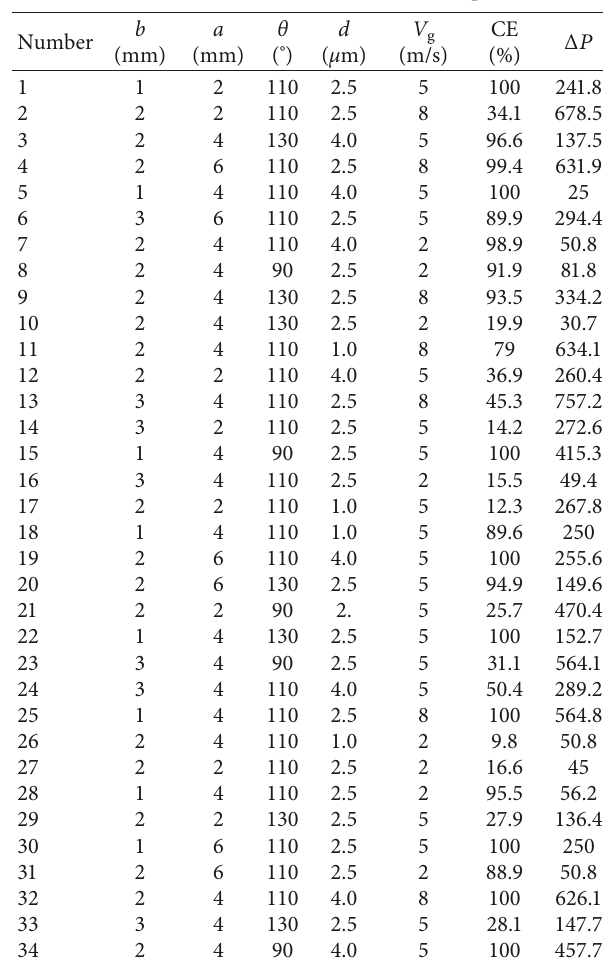
Figure 7: (a) The influence of turning angle on pressure drop; (b) the influence of pipe length on pressure drop. Table 2: Test results of 41 cases with various